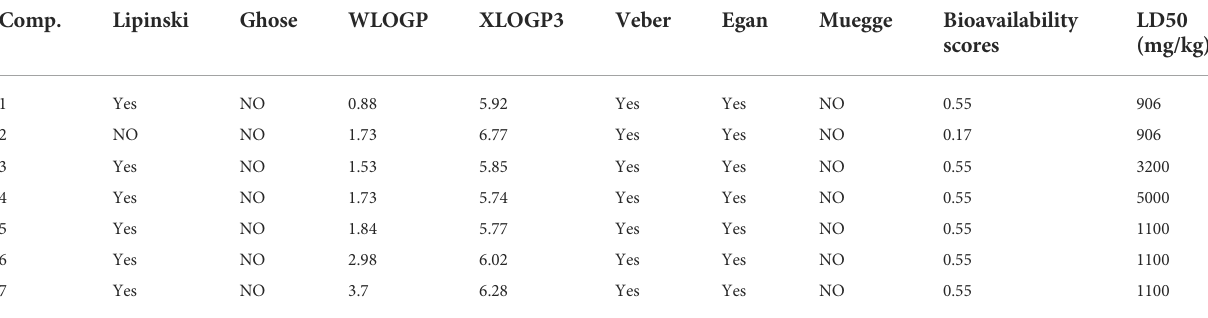
TABLE 7 The bio-availability, Druglikeness and Toxicity properties of the synthesized complexes. Toxicity evaluation result (LD50). Evaluation processed by ProTox-II server (https://tox-new.charite.de/).